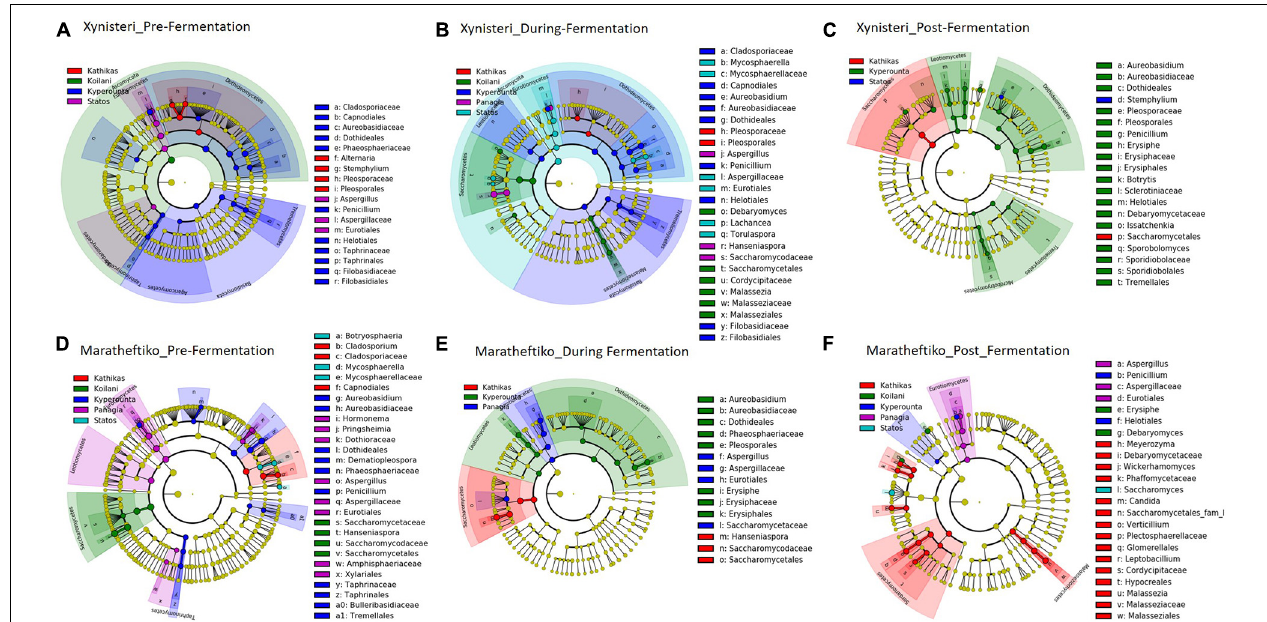
FIGURE 8 | LEfSe analyses of taxon abundances of over-represented fungal taxa among grape wine varieties and among stages of fermentation. (A) Variety Xynisteri pre-fermentation; (B) variety Xynisteri during fermentation; (C) variety Xynisteri post-fermentation; (D) variety Maratheftiko pre-fermentation; (E) variety Maratheftiko during fermentation; (F) variety Maratheftiko post-fermentation.